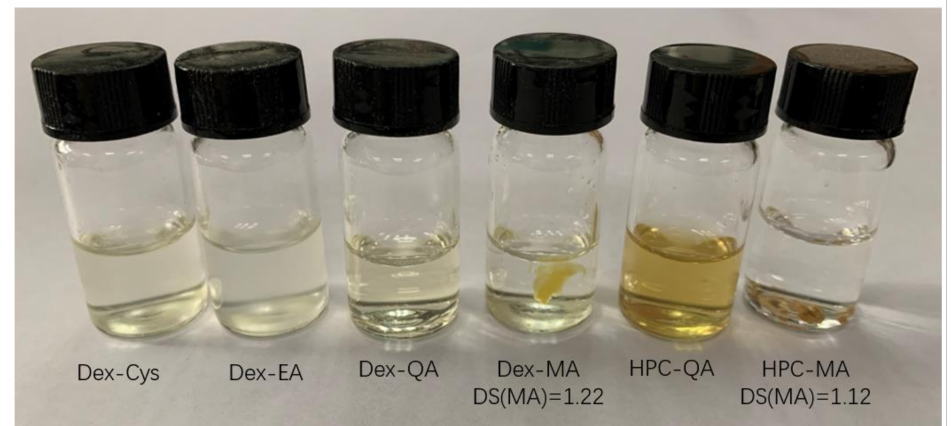
Figure 5. Water solubility of dextran and HPC derivatives (from left to right, Dex-Cys, Dex-EA, Dex-QA, Dex-MA, HPC-QA and HPC-MA).